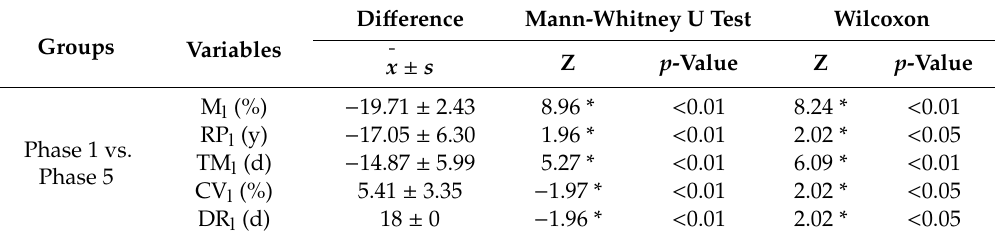
Di ff erences significance tests of low flow regime components in hydropower dam disturbance period. Di ff erence Mann-Whitney U Test Groups Variables